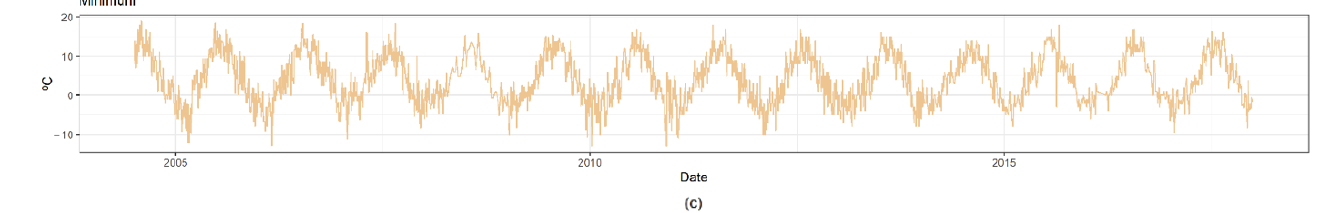
Figure 7. Series of temperatures. ( a ) Series of maximum temperature; ( b ) Series of medium temperature; ( c ) Series of minimum temperature.